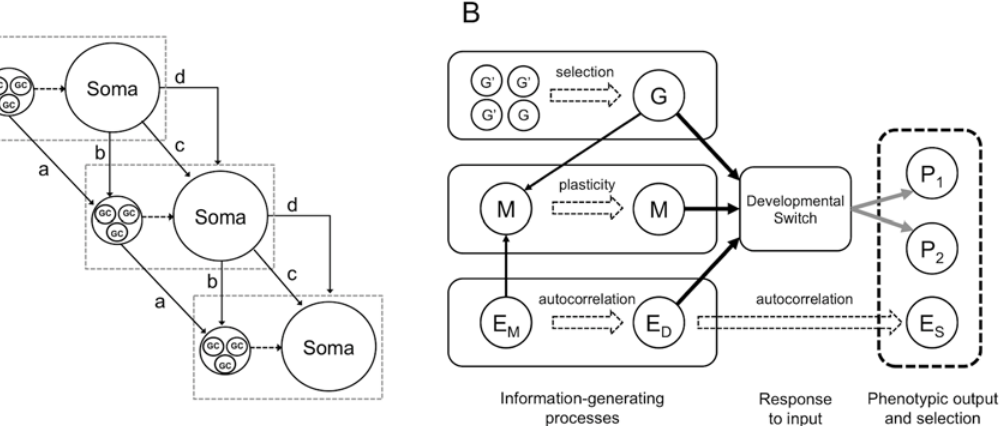
Figure 1. Inheritance pathways and model framework. A. Different pathways of inheritance, including (a) direct germline transmission between germ cells (GC) across generations (e.g inheritance of DNA or DNA methylation marks due to incomplete resetting); (b) effect of parental phenotype on germ cells of next generation (e.g. environmentally-induced changes in methylation status in early embryos); (c) effect of parental phenotype on offspring phenotype (e.g. large mothers producing large offspring); (d) effects of parental phenotype on offspring environment (dotted box) (modified in part from [11]). B. The model framework: evolution of a developmental switch that can respond to three sources of input, genetic loci (G), maternal phenotype (M), and environment (E). All three sources of input can carry information as follows (left hand side, from top to bottom). First, at the outset, G arises by a random process (e.g. mutation from G ’ ! G) and leads to, and correlates with, phenotype P i ; after one or several rounds of selection, G correlates both with P i and with some environmental factor(s) experienced by the offspring E S in virtue of which G was selected. Second, the maternal phenotype can carry correlational information about the selective regime in E S if it correlates with G and/or if the maternal environment that influences the expression of M (E M ) shows autocorrelation with the environment of the offspring at the time of selection (E S ). Finally, the environment of development (E D ) can carry correlational information about the environment of selection (E S ). Note that figure B omits additional links arising from, for example, niche construction, where ancestors affect E s directly [5] and genetic differences that cause variation in parental contribution to offspring (e.g. [83]). All three sources of input can affect the liability of a developmental switch (thick black arrows), which in response can produce a range of phenotypes (grey arrows), P i (here i = 2). Phenotypes are subject to selection (dashed box) as a result of variation in the environment ( E S ). Thus, adaptive evolution of the developmental switch is expected to increase the match between phenotype, P i , and the selective environment, E S , by modifying the response to genetic, maternal, or environmental